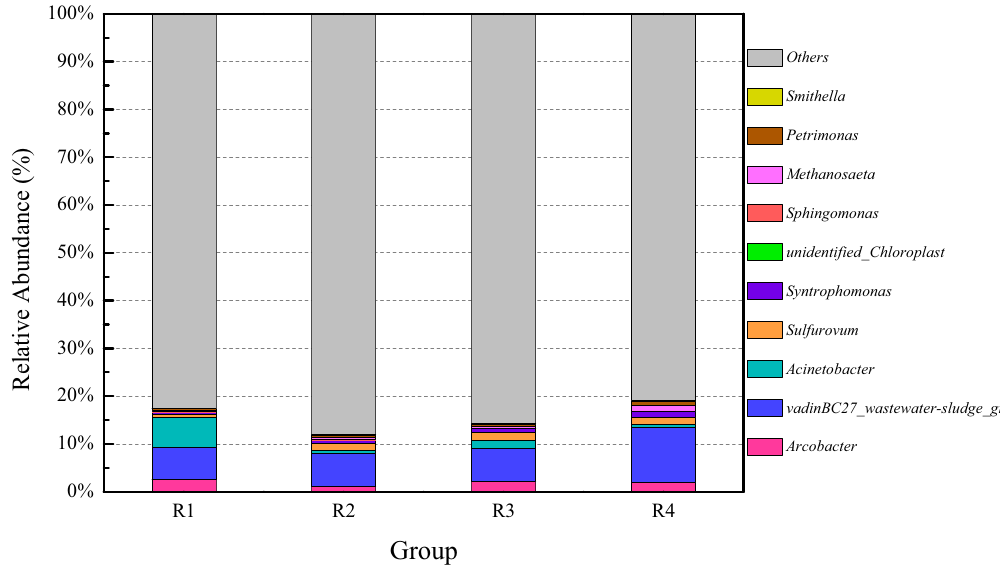
Figure A2: Relative abundance of microbial communities at the genus levels in the peak gas production of anaerobic digestion system of cattle manure at medium to low